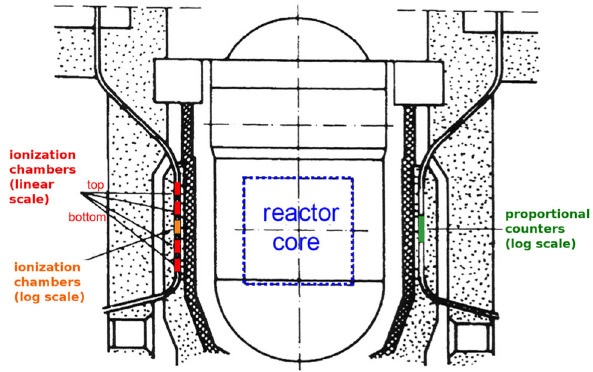
Fig. 4 External neutron measurement system at nuclear power plant in Brokdorf (ex-core instrumentation, linear scale: standard reactor oper- ation, log scale: when the reactor is turned ON and